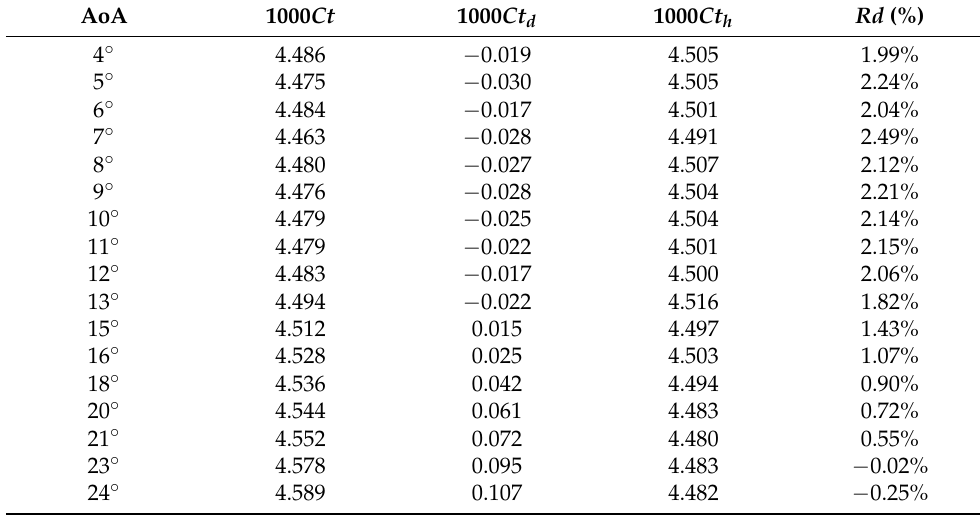
Table 5. Energy saving result of duct